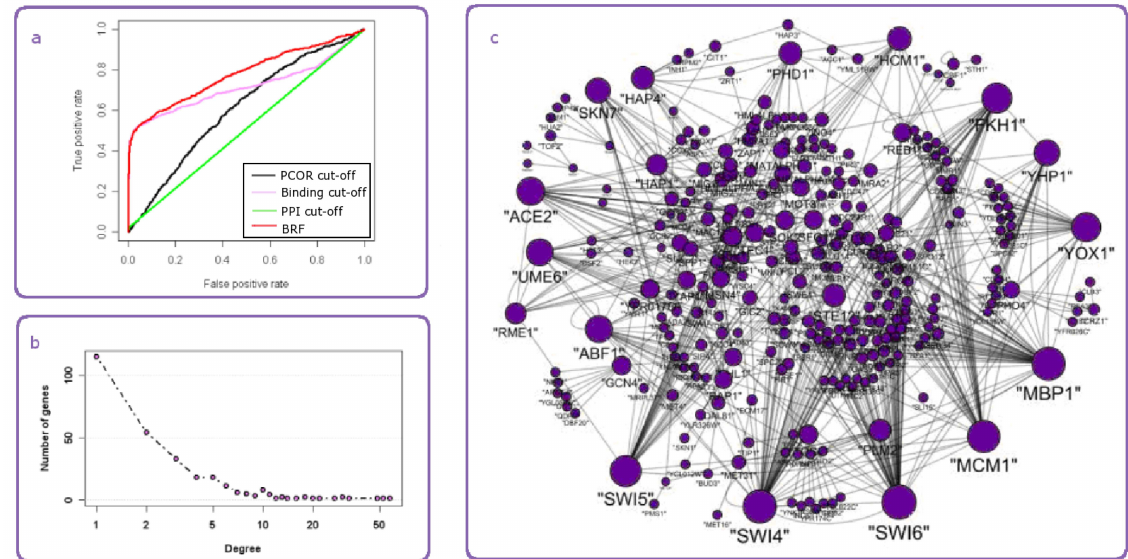
Figure 2: (a) ROC curves for threshold selection methods for the three data types used in network reconstruction and the resultant network by BRFs, (b) Connectivity degree distribution of the sub-network, x axis shows the degree of connectivity of 296 nodes in log 2 scale, (c) The inferred cell cycle specific sub-network, size of the nodes indicate their degree of connectivity